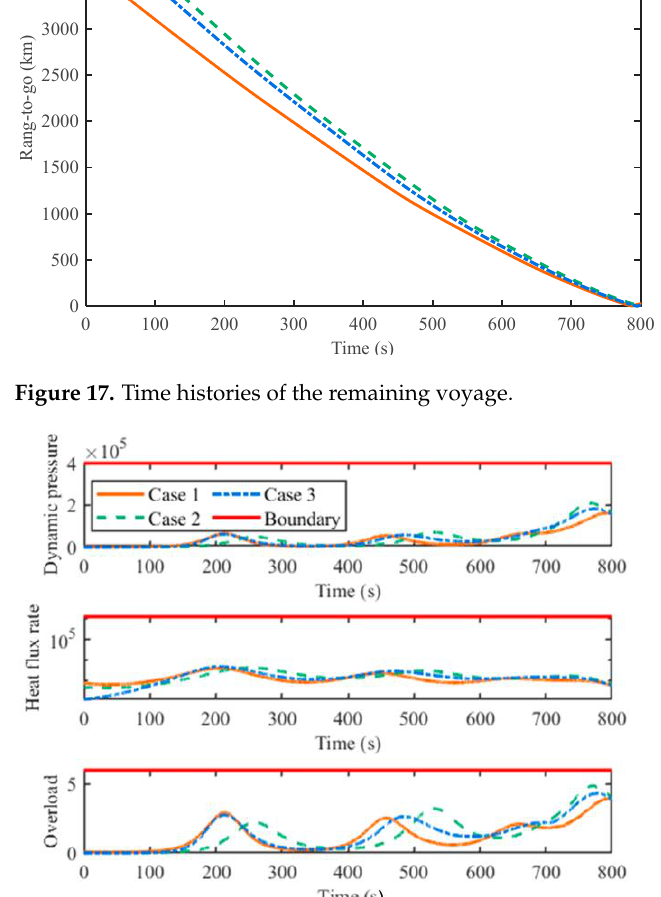
Figure 18. Time histories of the path constraints.